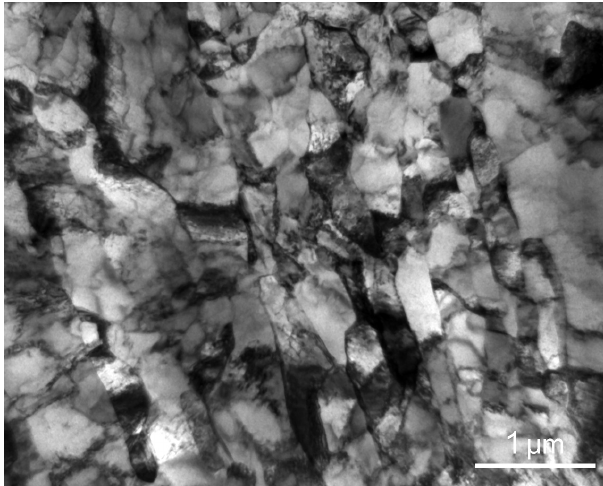
Figure 2b: Microstructure of Cu after ECAP as observed in TEM, transversal